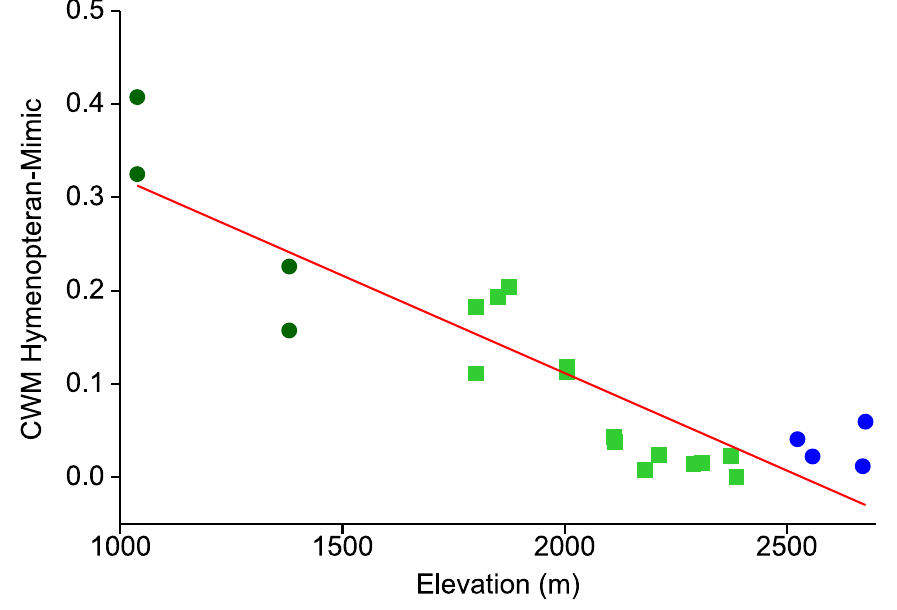
Figure 3. CWMs of hymenopteran mimicry among 22 local Arctiinae assemblages in an elevational gradient in the tropical Andes of southern Ecuador. Dark green dots: premontane forest; lime green squares: lower montane forest; blue filled circles: upper montane Purdiaea nutans forest. The red line represents an OLS regression.